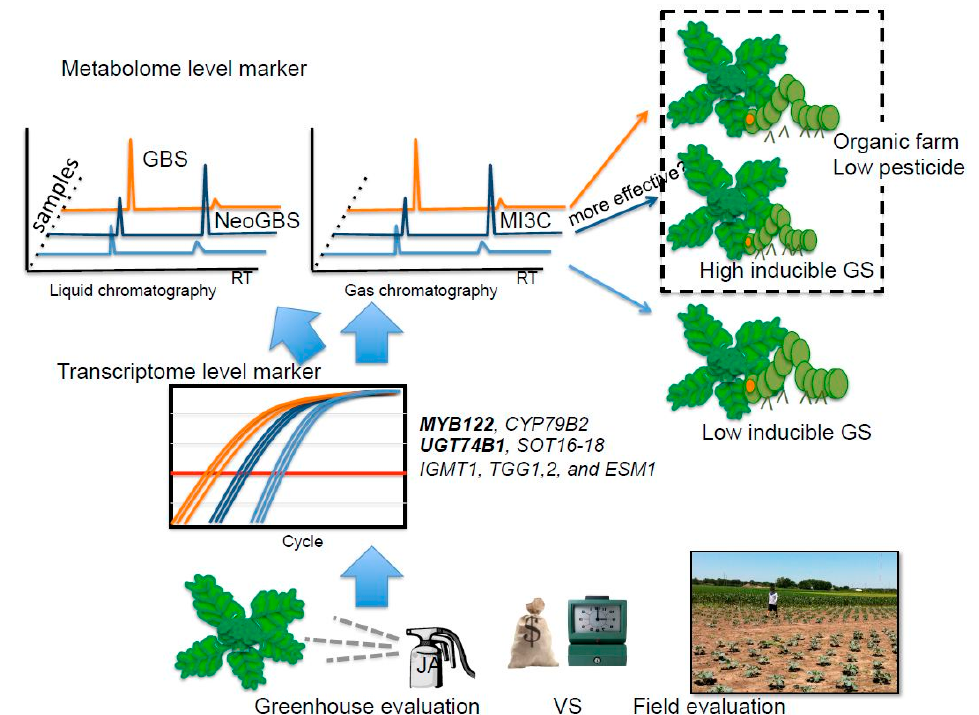
Figure 5. Possible breeding scheme for insect resistant germplasm by using JA/MeJA application to evaluate inducible GS and other defense mechanisms at the metabolite and transcriptome level. GBS:glucobrassicin, NeoGBS: neoglucobrassicin; MI3C: N -methoxyindole-3-carbinol. Transcript